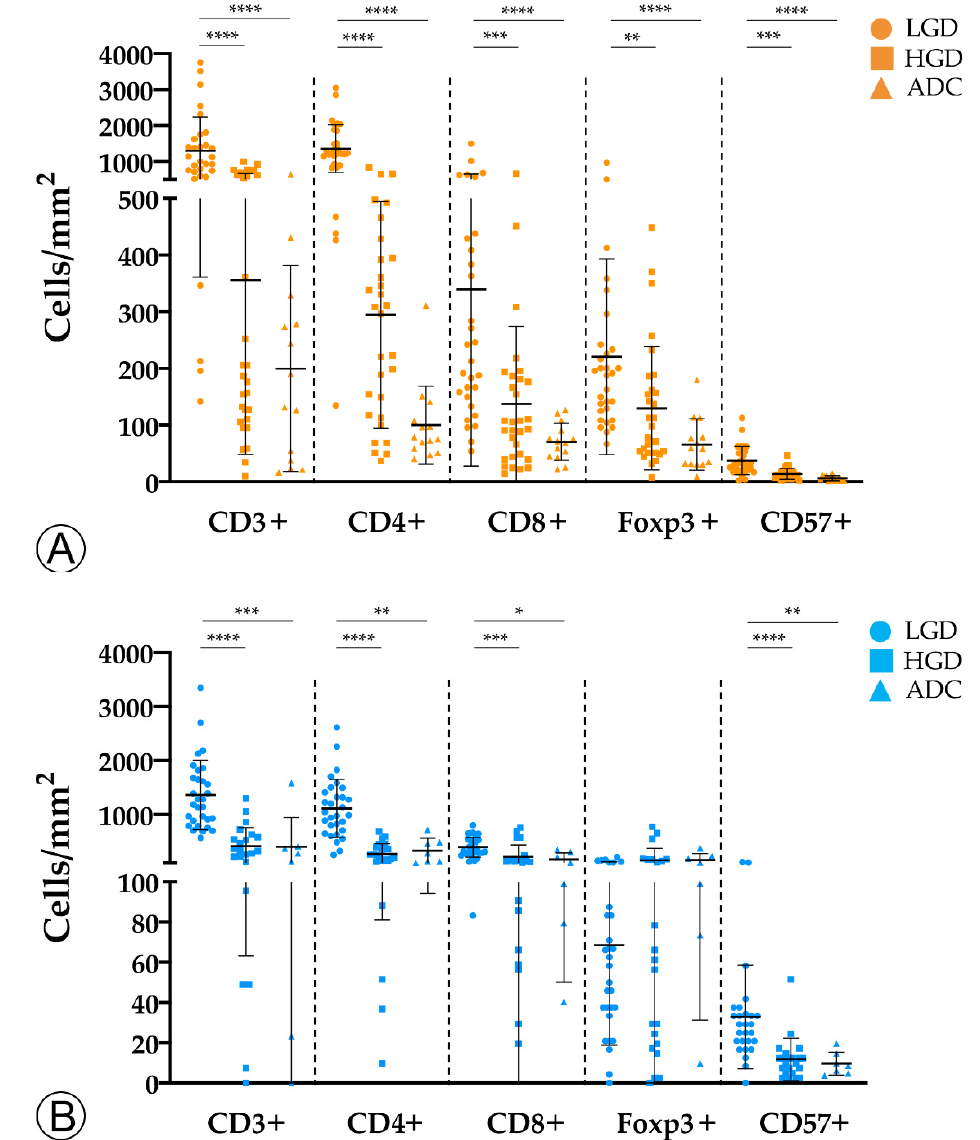
Figure 2. Counts of immune cells along the colorectal adenoma-carcinoma sequence in sporadic ( A ) and hereditary Familial Adenomatous Polyposis (FAP)-related ( B ) lesions. LGD, low-grade dysplasia; HGD, high-grade dysplasia; ADC, invasive adenocarcinoma; * = p < 0.05; ** = p < 0.01; *** = p < 0.001; **** = p < 0.0001.